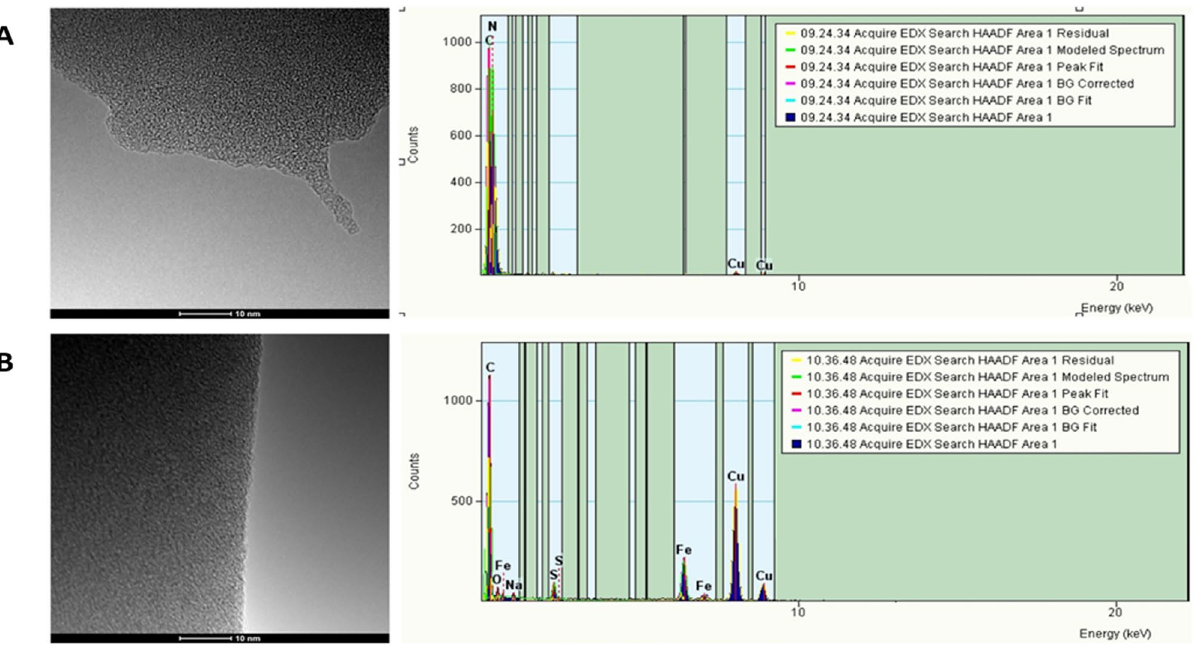
Figure 2. The TEM images and EDX spectra of ( A ) native bLTF and ( B ) Fe-bLTF